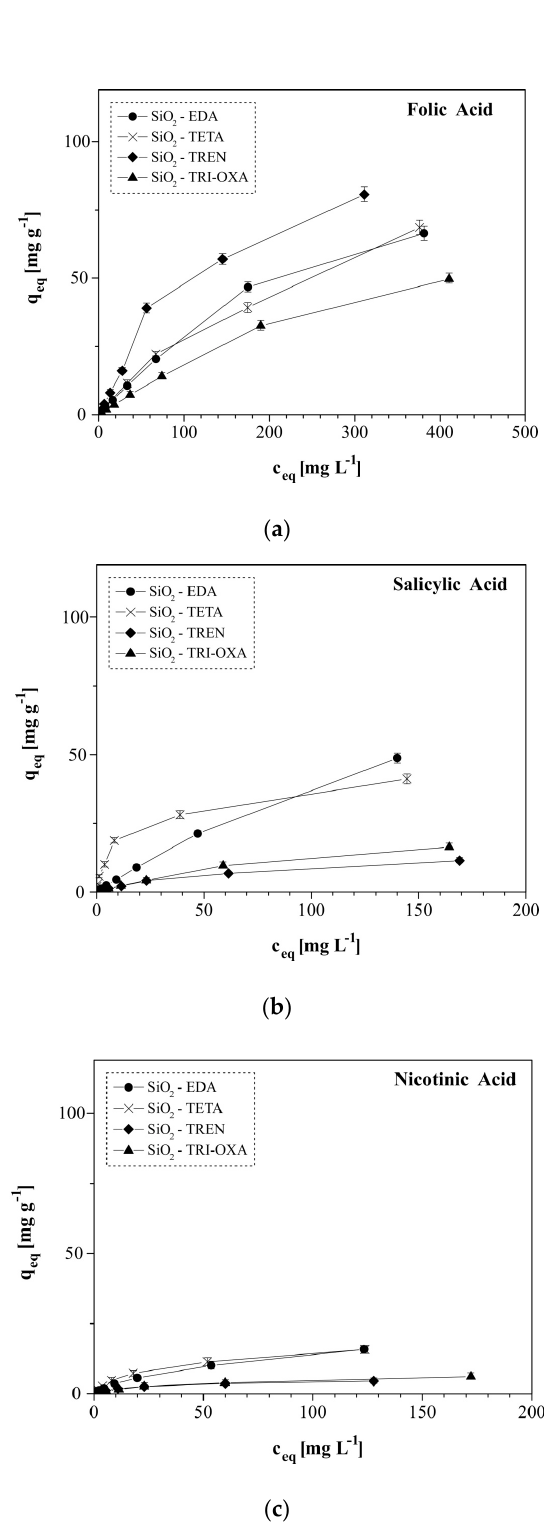
Figure 5. The isotherms of the acidic drugs’ adsorption on the obtained hybrid materials: ( a ) folic acid; ( b ) salicylic acid; and ( c ) nicotinic acid. For some points, the SDs are smaller than the plotted symbols.